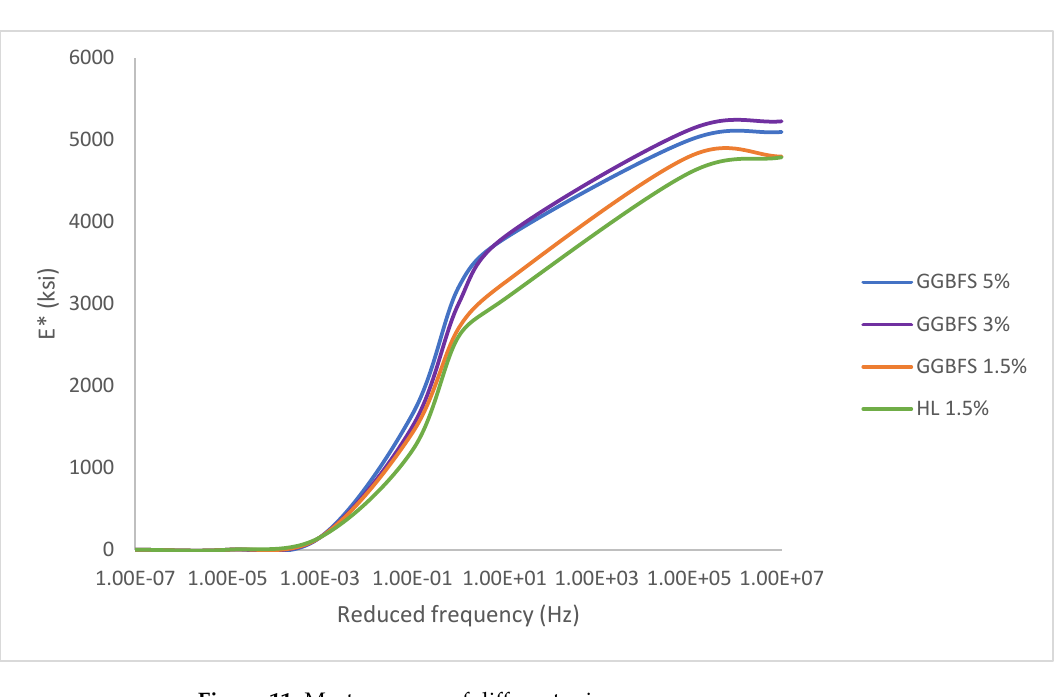
Figure 11. Master curves of different mixes.